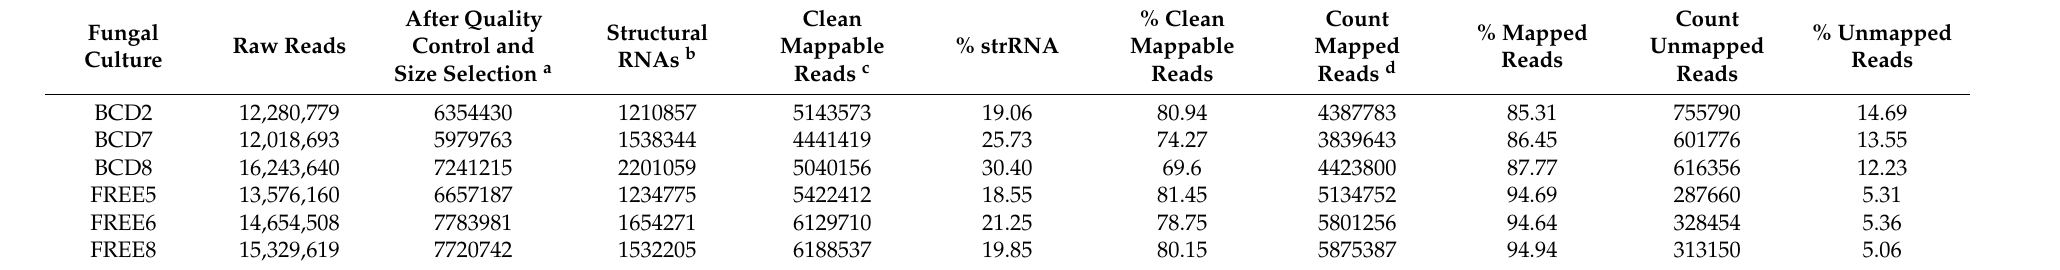
Table 3. Summary of total small RNA sequencing data and reads mapped to the Ceratobasidium isolate C02 genome